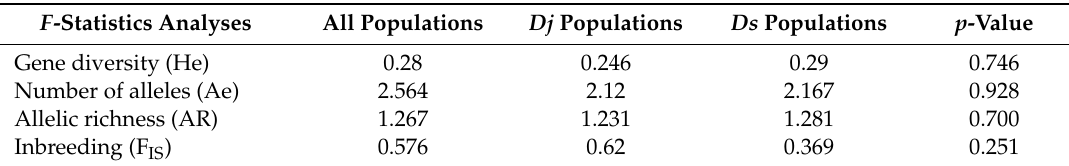
Table 3. F -statistics analyses averaged for all six loci. p -values are based on t -tests for di ff erence between Dryophytes japonicus ( Dj ) and Dryophytes suweonensis ( Ds ) in